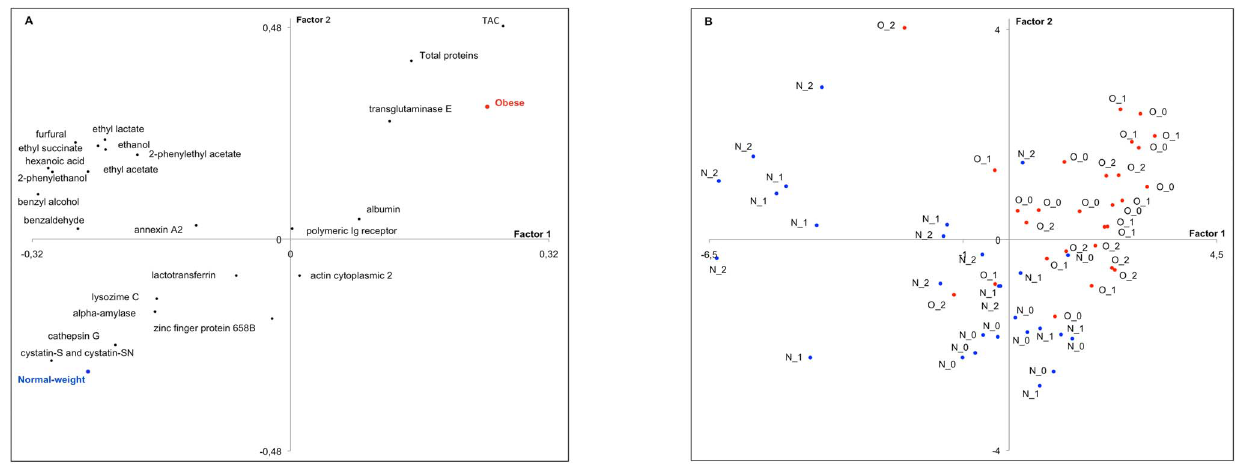
N N Figure 5. PLS-DA calibration modelling. Weighted loading plot (A) and scatter plot of scores (B) for X-variables, and their inner relationships with ) and N (blu ) for the first two latent variables (43% of the total variance in the X-block; 56% of the total variance in the Y-block). O (red